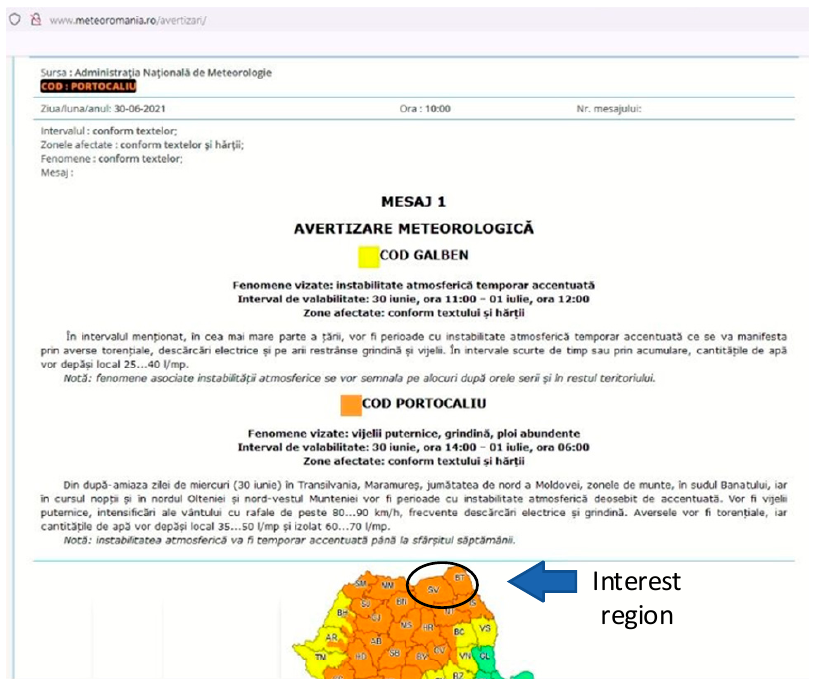
Figure 11. Example of Romanian weather warning, from 30 June 2021 to 1 July 2021.